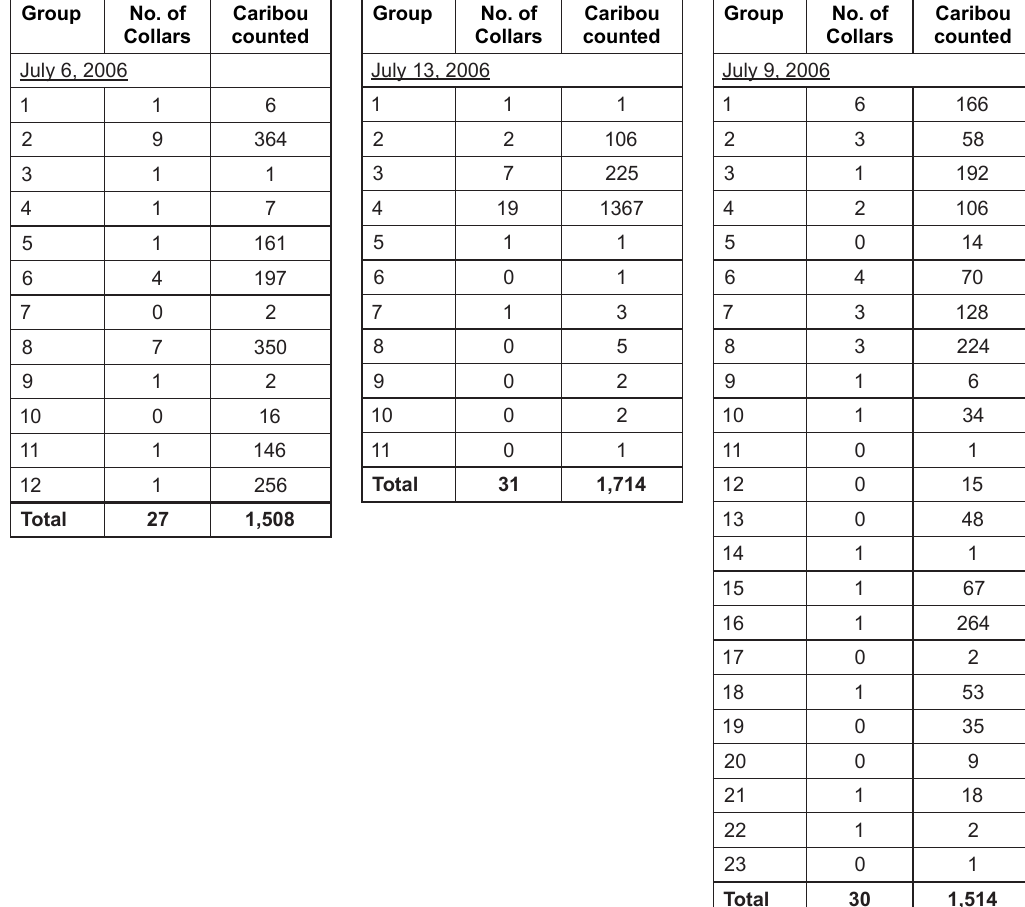
Table 25. Summary of field data on three dates for the Cape Bathurst herd in